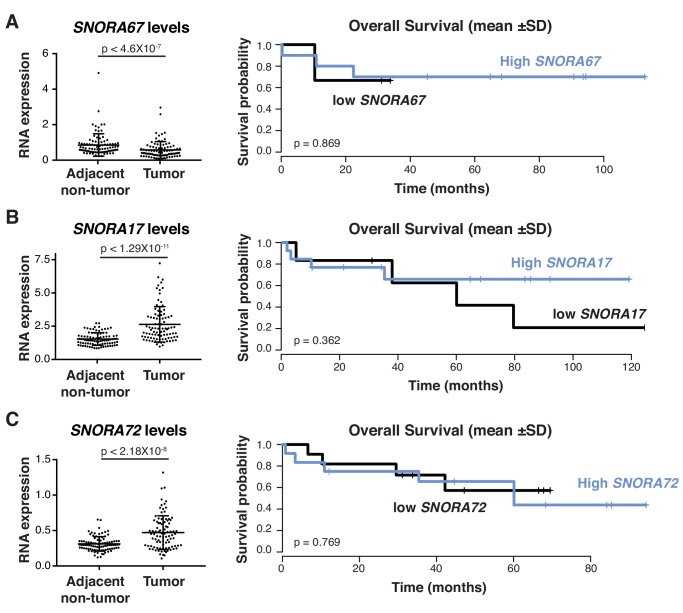
Association between H/ACA snoRNA levels and patient survival in HCC.(A) Analysis of SNORA67 levels in HCC specimens compared to adjacent non-tumor tissue of 91 HCC patients (GSE25097) (paired Student’s t-test, p<4.6×10−7) (left panel) and Kaplan-Meier curve showing overall survival of HCC patients with high or low SNORA67 levels (mean ± 1 SD of SNORA67 levels) (right panel). (B) Analysis of SNORA17 levels in HCC specimens compared to adjacent non-tumor tissue of 91 HCC patients (GSE25097) (paired Student’s t-test, p<1.29×10−11) (left panel) and Kaplan-Meier curve showing overall survival of HCC patients with high or low SNORA17 levels (mean ± 1 SD of SNORA17 levels) (right panel). (C) Analysis of SNORA72 levels in HCC specimens compared to adjacent non-tumor tissue of 91 HCC patients (GSE25097) (paired Student’s t-test, p<2.18×10−8) (left panel) and Kaplan-Meier curve showing overall survival of HCC patients with high or low SNORA72 levels (mean ± 1 SD of SNORA72 levels) (right panel).